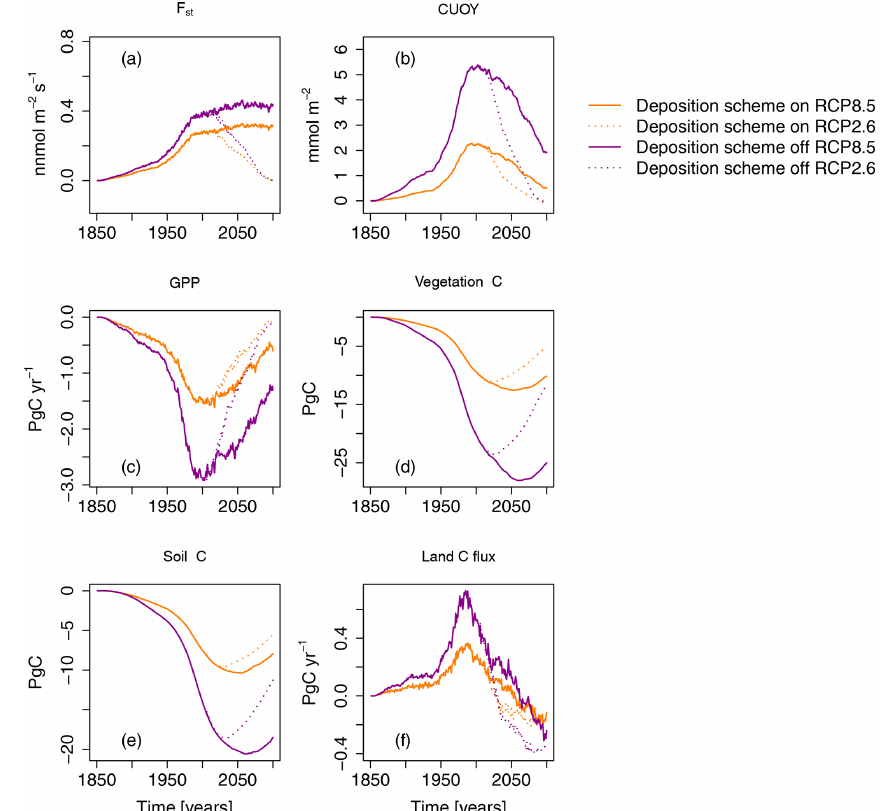
Figure 9. Ozone impacts on the regional mean O 3 uptake ( F st ), mean cumulative O 3 uptake above a flux threshold of 1nmolm − 2 s − 1 (CUO1), summed GPP, total carbon biomass in vegetation (vegetation C), summed carbon soil organic matter (soil C), and summed land car- bon flux (land C flux) compared to preindustrial values in the simulation region. The displayed O 3 impact is calculated based on approach 2. Orange lines indicate results based on a model version in which the O 3 deposition scheme is turned on. Magenta lines indicate results based on a model version in which the O 3 deposition scheme is turned off. Solid lines indicate results from simulations based on RCP8.5, and dotted lines are results from simulations based on RCP2.6. The effect of the seasonal cycle is smoothed by the application of a moving average of 12 months (a, b)